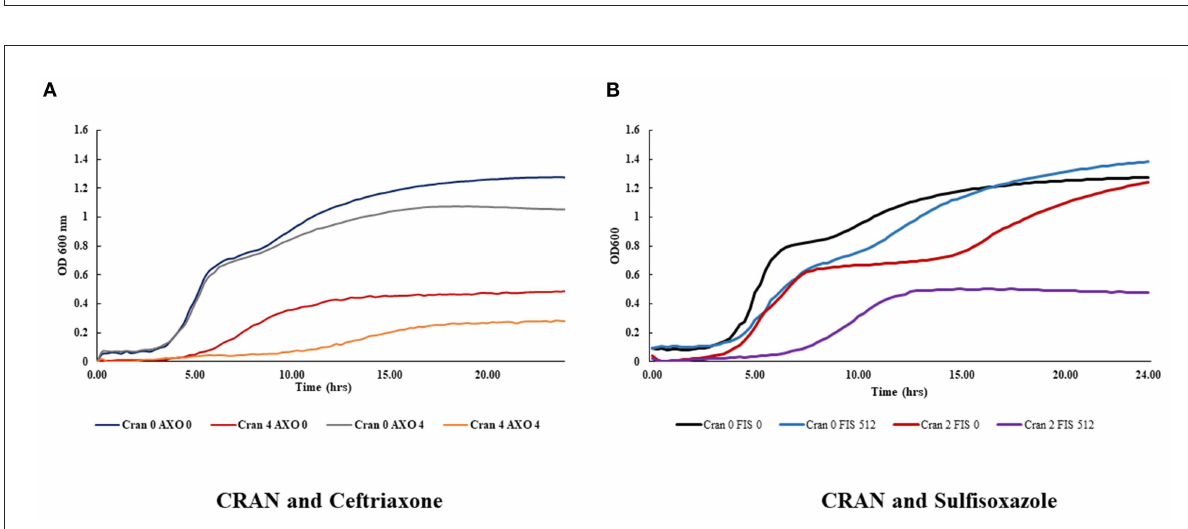
FIGURE2 Growth kinetics of E. coli O7:H18 (ST38) was monitored by the Bioscreen C in a checkerboard assay in the combination of sub-lethal concentrations of cranberry pomace extracts (CRAN) and (A) ceftriaxone (AXO) or (B) sulfisoxazole (FIS).